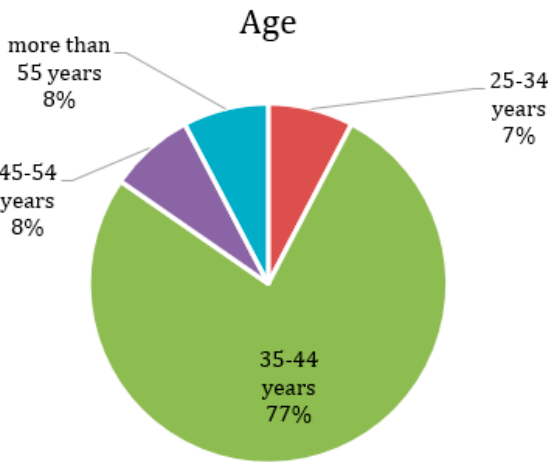
Figure 3. Representation of drivers in terms of age.